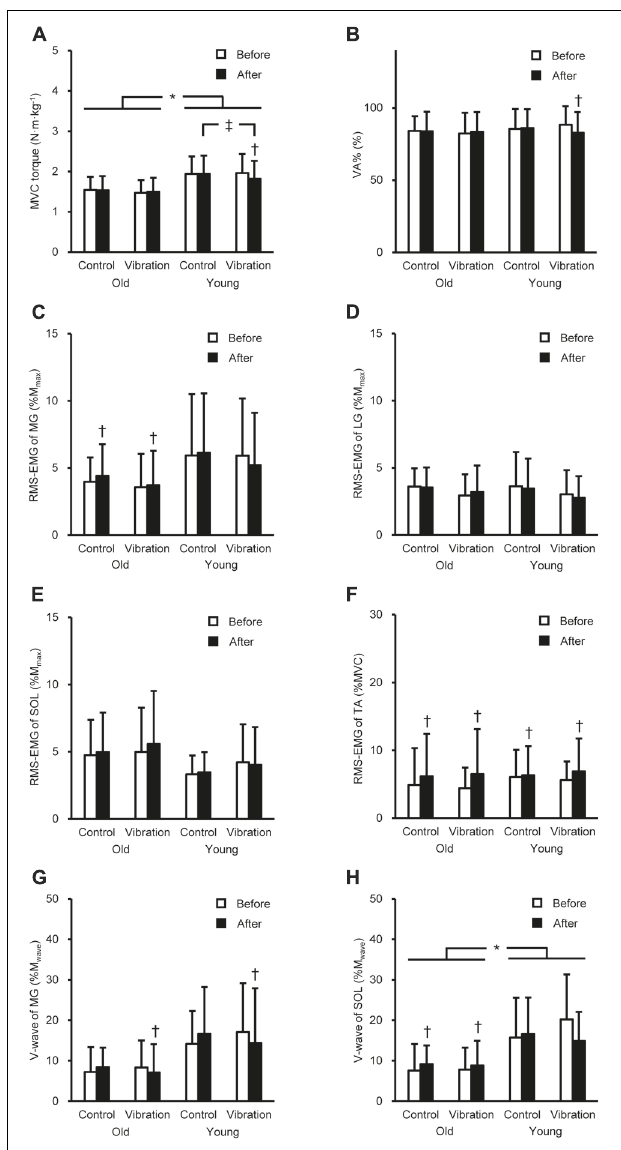
FIGURE 1 | Peak torque during maximal voluntary contraction (MVC, A ) of plantar flexion, voluntary activation (VA%, B ), root mean square of the electromyogram (RMS-EMG) of the medial gastrocnemius (MG, C ), lateral gastrocnemius (LG, D ), soleus (SOL, E ), and tibialis anterior (TA, F ), and V-wave of MG (G) and SOL (H) during plantar flexor MVC before and after the intervention. Data are shown as mean + standard deviation. RMS-EMGs of the triceps surae and V-waves were normalized to the peak-to-peak compound muscle action potential amplitude at rest (M max ) and during MVC (M wave ), and RMS-EMG of TA was normalized to that during dorsiflexor MVC. *Indicates a significant difference between older and young men. † Denotes a significant change after the intervention. ‡ Shows a significant difference between control and vibration